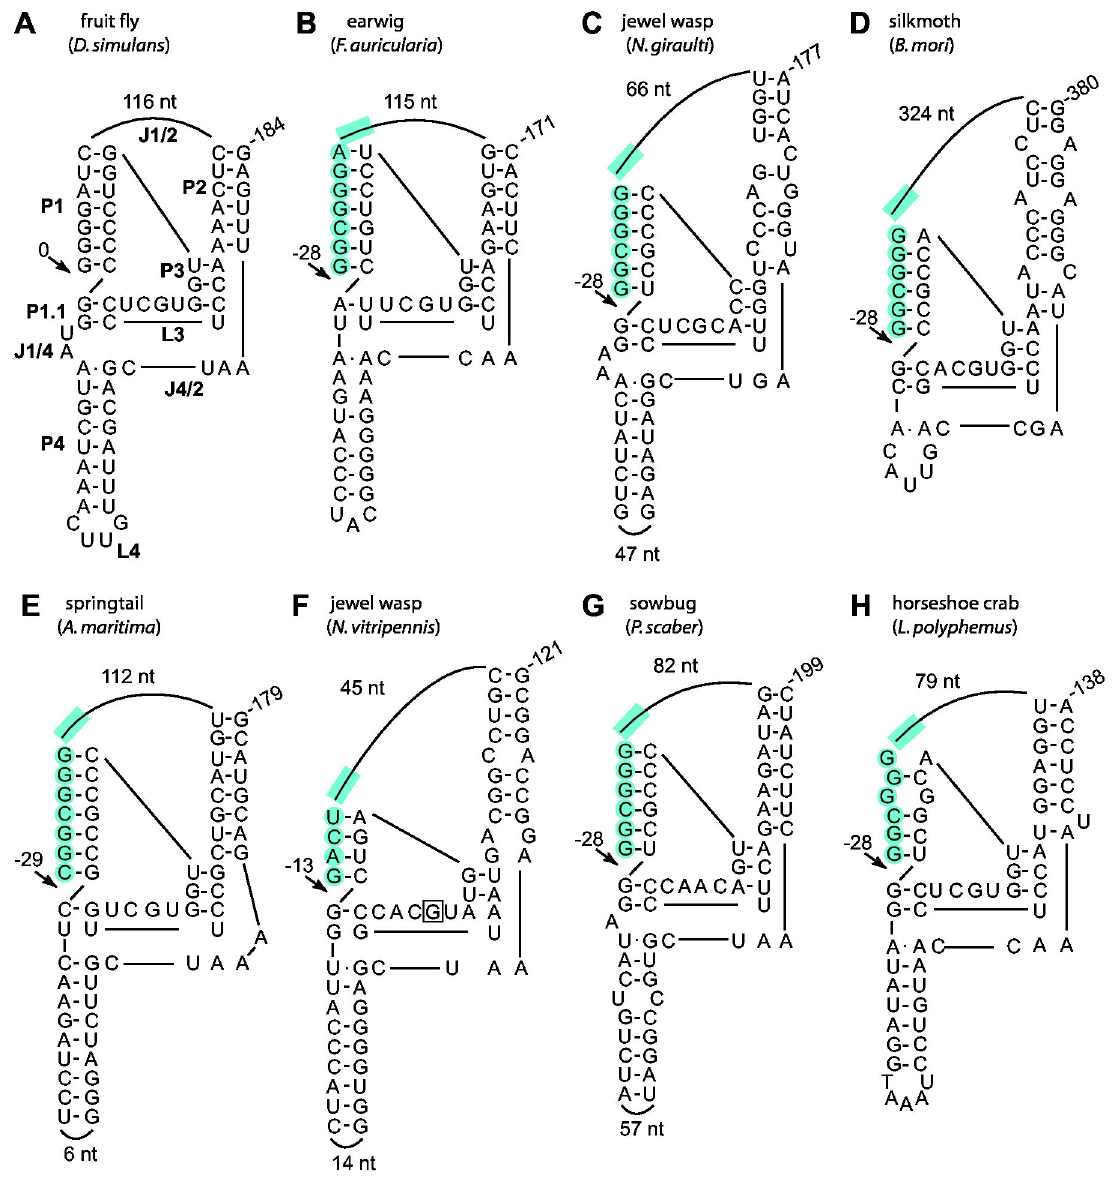
Figure 3. 28S/R2 RNA sequences from divergent arthropods fold into structures similar to the ribozyme from Drosophila. (A) Diagram of the R2 ribozyme from D. simulans ; P, base-paired region, L, loop at end of a P region; J, nucleotides joining base-paired regions [11]. (B) through (H) Predicted secondary structures of the 28S/R2 junctions from seven arthropods. Only the number of R2 nucleotides in the J1/2 loop and the number of nucleotides in the L4 loop if it is large are shown. The presence of 28S gene sequences within the ribozyme is indicated with blue shading. Arrows indicate the observed or predicted R2 self-cleavage sites relative to the 3' R2 insertion site. A 'G' to 'A' nucleotide substitution at the boxed position in the N. vitripennis structure was observed to affect self-cleavage (Figure 2). Partial structures for earwig and horseshoe crab and an alternative P1 for silkmoth were previously predicted [12]. doi: 10.1371/journal.pone.0066441.g003 detectable self-cleavage (Figure 4C, lanes 9 and 10); however, (Figure 4C, lane 8). To determine what region was required for RNA with 126 nucleotides had a level of self-cleavage cleavage, increasingly longer segments starting from the 3' end comparable to the control template (Figure 4C, lanes 11 and of the loop were added back to the ribozyme (Figure 4B). RNAs with 20 or 90 nucleotides of the loop showed no